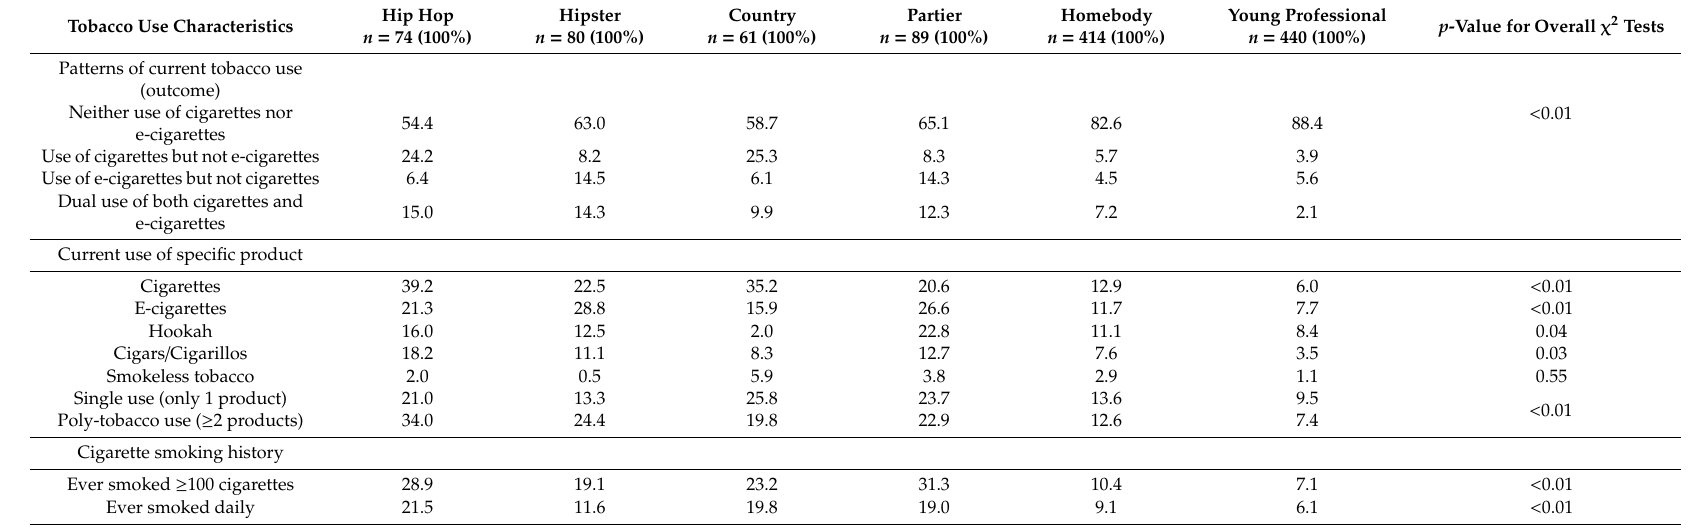
Table 2. Tobacco use characteristics by peer crowd (weighted